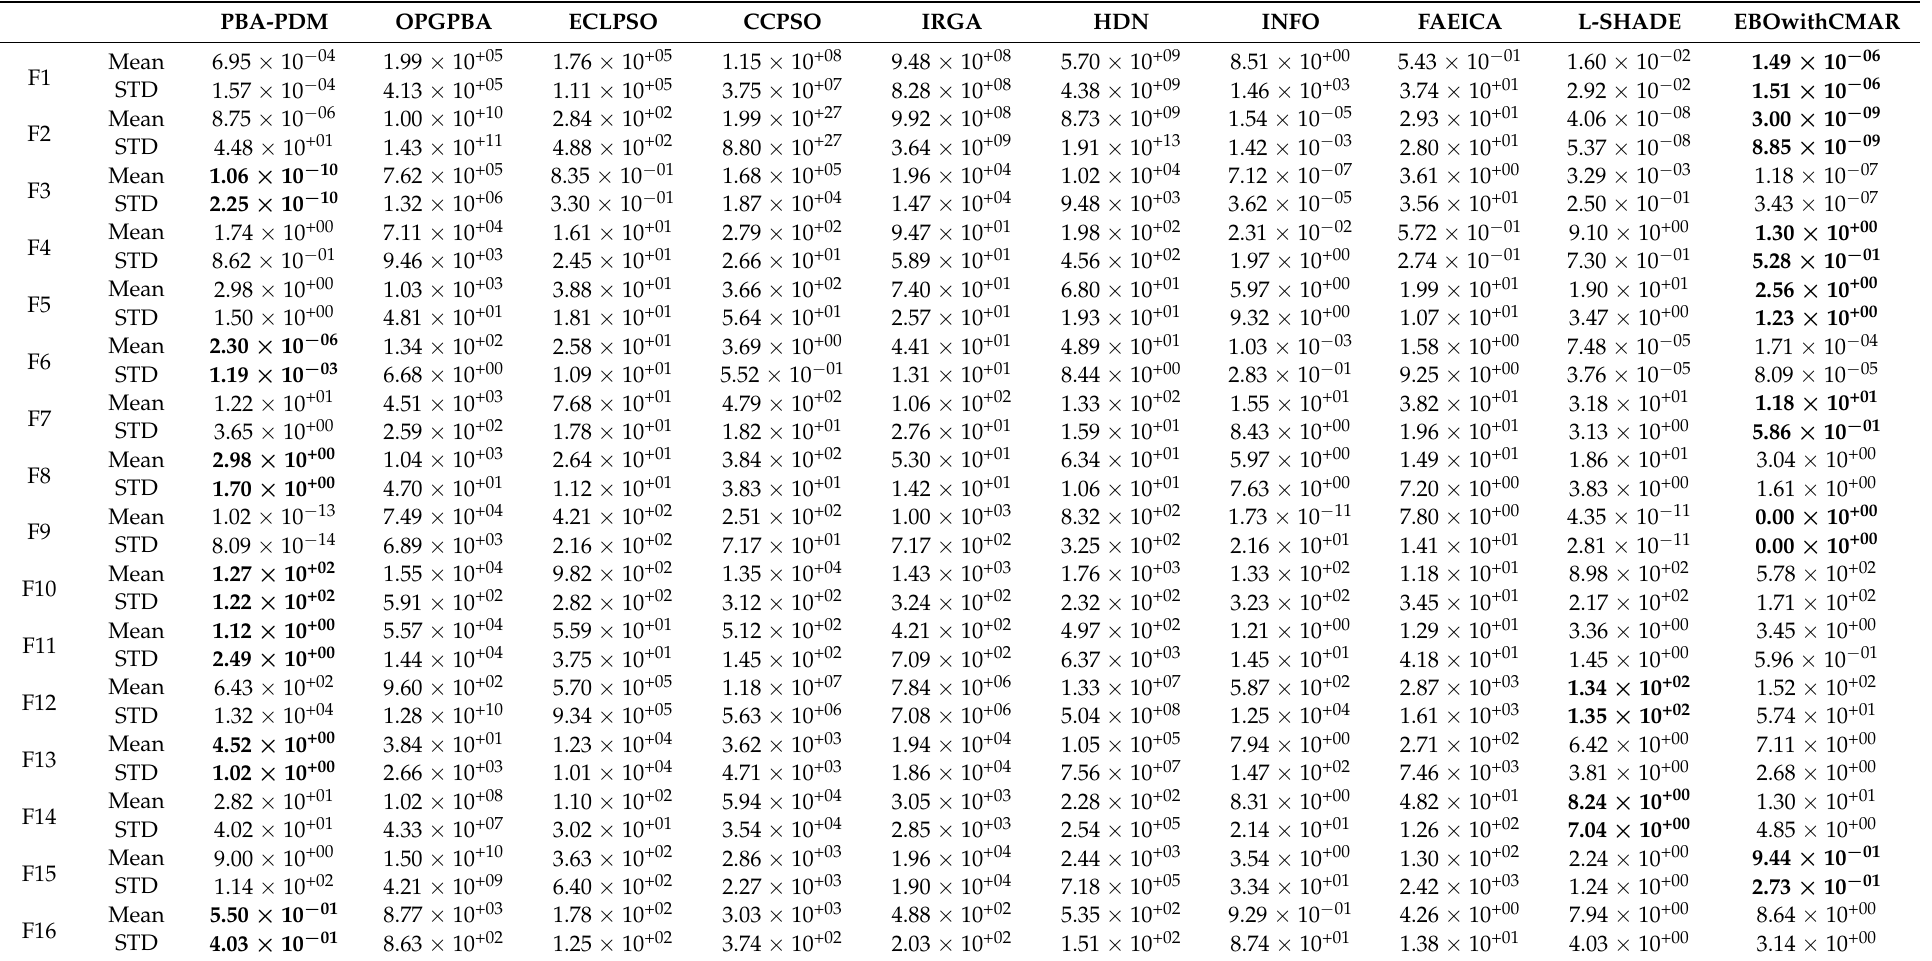
Table 7. Comparative results of the CEC2017 benchmark test functions in 10